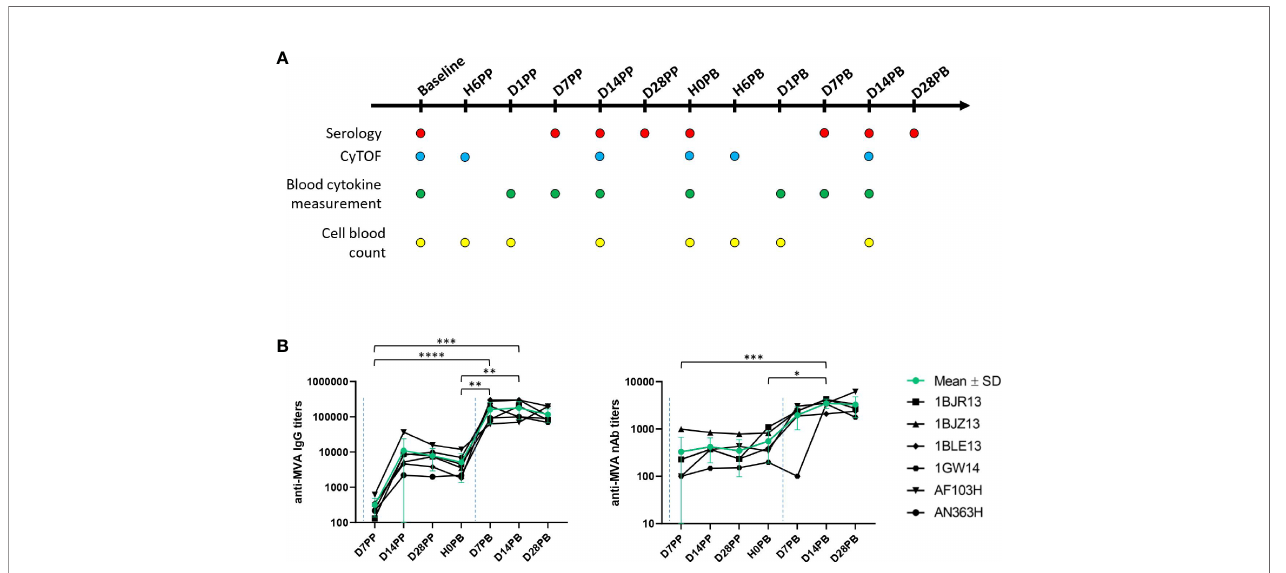
FIGURE 1 | Experimental approach. (A) Experimental design. Six male and adult cynomolgus macaques were immunized two months apart with MVA HIV-B at a dose of 4 x 10e 8 PFU injected intradermally (ID). Blood was drawn longitudinally at hours (H for hour), days (D for day), or months (M for month) before and after the fi rst (PP for post-prime) and second (PB for post-boost) immunization to assess the in fl ammatory, innate, and humoral responses, and the phenotype of blood innate myeloid cells by mass cytometry. Immunizations are indicated by the blue dotted lines (B) Immunogenicity of MVA injected ID. Individual (black) and mean (green, with standard deviation) titers of anti-MVA IgG (left) and nAb (right) in EDTA plasma were plotted over time. Anti-MVA IgG titers were measured by ELISA. The MVA neutralizing capacity was quanti fi ed using a cell-based assay and MVA-eGFP. Immunizations are indicated by the blue dotted lines. Titers were compared by Wilcoxon tests. Statistically signi fi cant p values (p < 0.05) are indicated by an asterisk (*). P < **0,01, P < ***0,001, P<